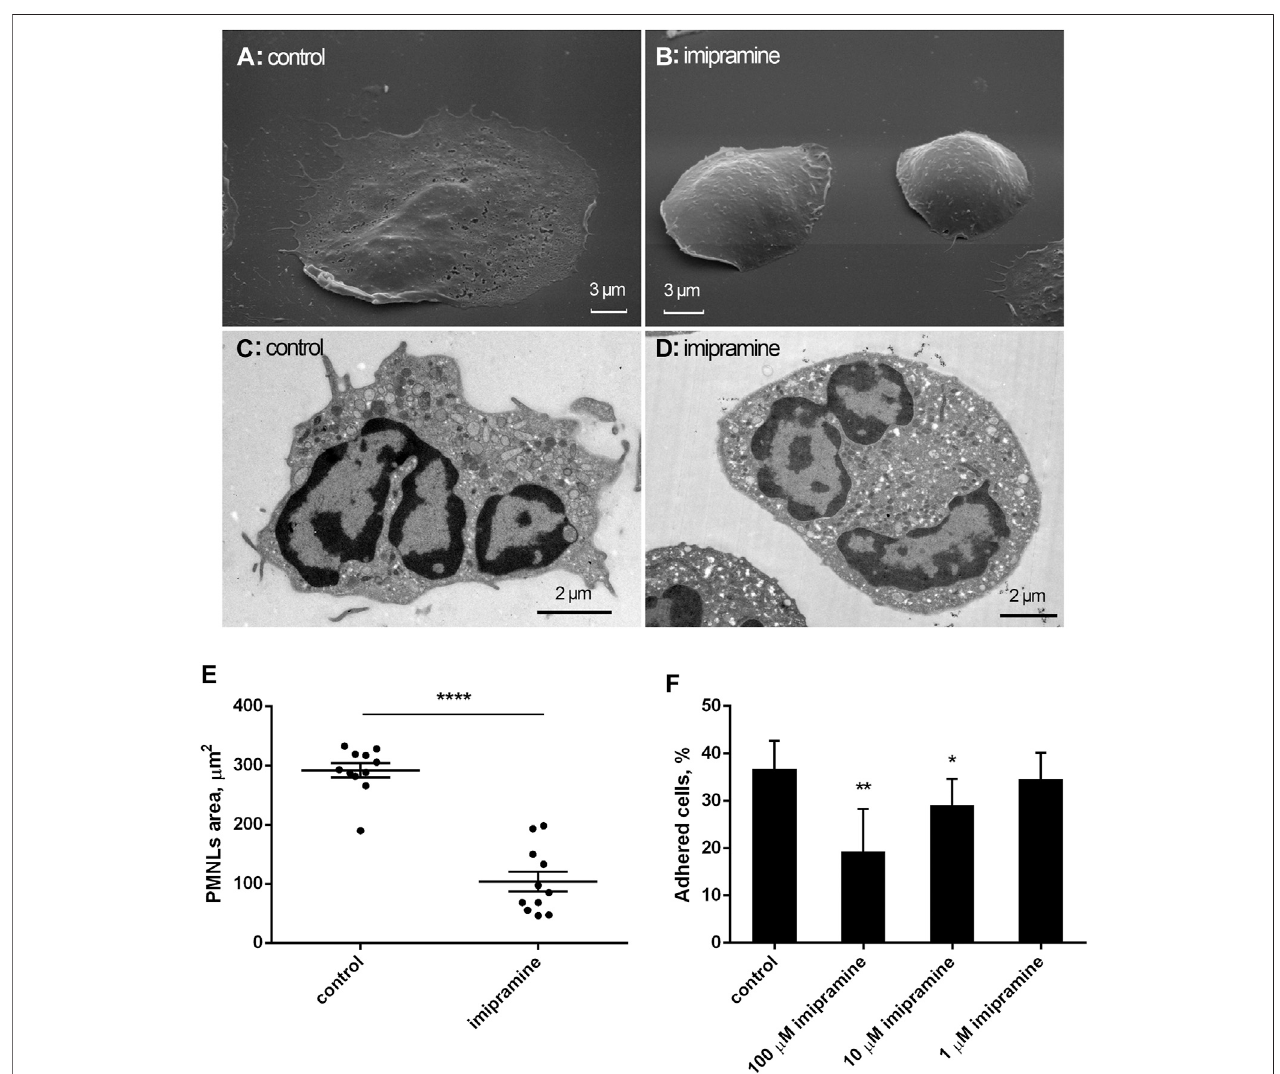
FIGURE 1 | Effect of imipramine on the morphology of neutrophils attached to a fi bronectin-coated substrate. Scanning (A, B) and transmission (C, D) electron microscopy images of human neutrophils that were attached to fi bronectin-coated substrates for 20 min under control conditions (A, C) or in the presence of 100 μ M imipramine (B, D) . Images are typical images observed in three independent experiments. The effect of imipramine on the area occupied by attached neutrophils on the substrate (E) . Neutrophils were attached to the substrate during 20 min under control conditions or in the presence of 100 µM imipramine. The cell area was measuredinimagesofcellsobtainedbyscanningelectronmicroscopyusingImageJ-win64software.**** — p < 0.0001asindicatedbyunpaired t test( n (cid:2) 11)Theeffect ofimipramineon theproportion ofneutrophils fi rmlyattached tothesubstrateasthepercentagesoftotal number ofcells (F) .Neutrophils wereattached tothesubstrate during 20 min under control conditions or in the presence of 1, 10 or 100 µM imipramine. After double washing with warm PBS to remove free- fl oating or weakly attached cells the number of adherent cells was estimated by chromogenic assay of myeloperoxidase-coupled o-phenylenediamine dihydrochloride oxidation. * — p < 0.05; ** — p < 0.01, compared with control as indicated by ordinary one-way ANOVA ( n (cid:2)